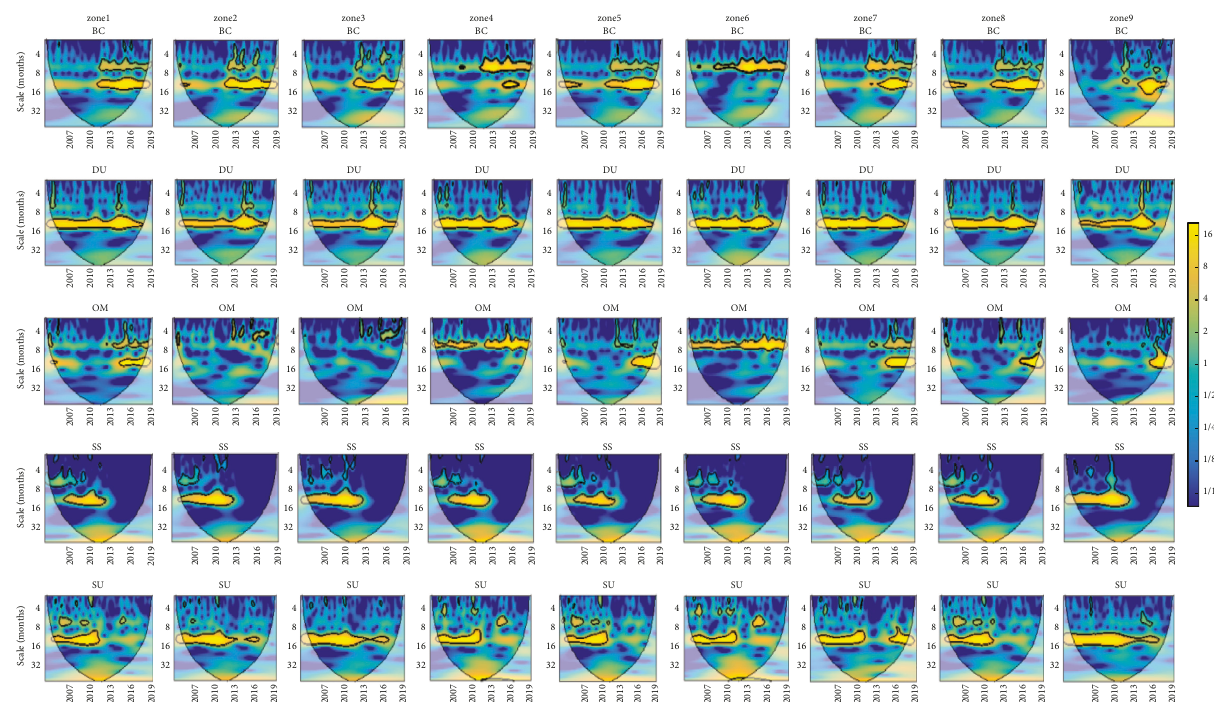
Figure 4: Continuous Morlet wavelet spectrum (CWS) of the five types of aerosols over the 9 selected zones on a monthly scale during 2005–2019. The thick black contours are the 95% confidence level of local power relative (significant periodicities are enclosed in that thick black contour line). The black line is the cone of influence beyond which the energy is affected by the zero-padding effect.